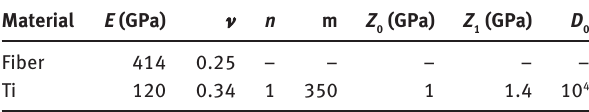
Table 2: Material parameters of fiber and Ti matrix. Material